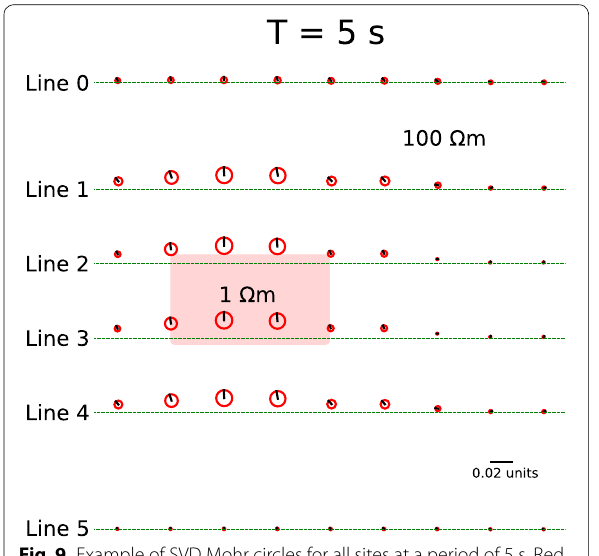
Fig. 9 Example of SVD Mohr circles for all sites at a period of 5 s. Red rectangle represents the 1 (cid:31) m conductive block, and the background resistivity is 100 (cid:31) m. Green horizontal lines represent the D ′ xy axes